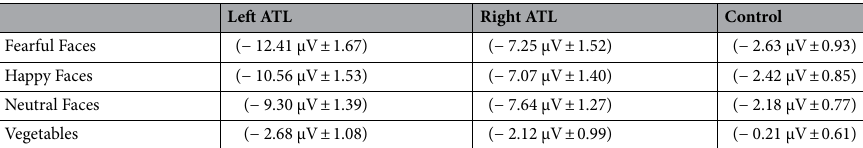
Table 1. Mean amplitude values and standard errors of the N170 for fearful, happy, neutral faces and vegetables for the left and right ATL patients and for the control group.